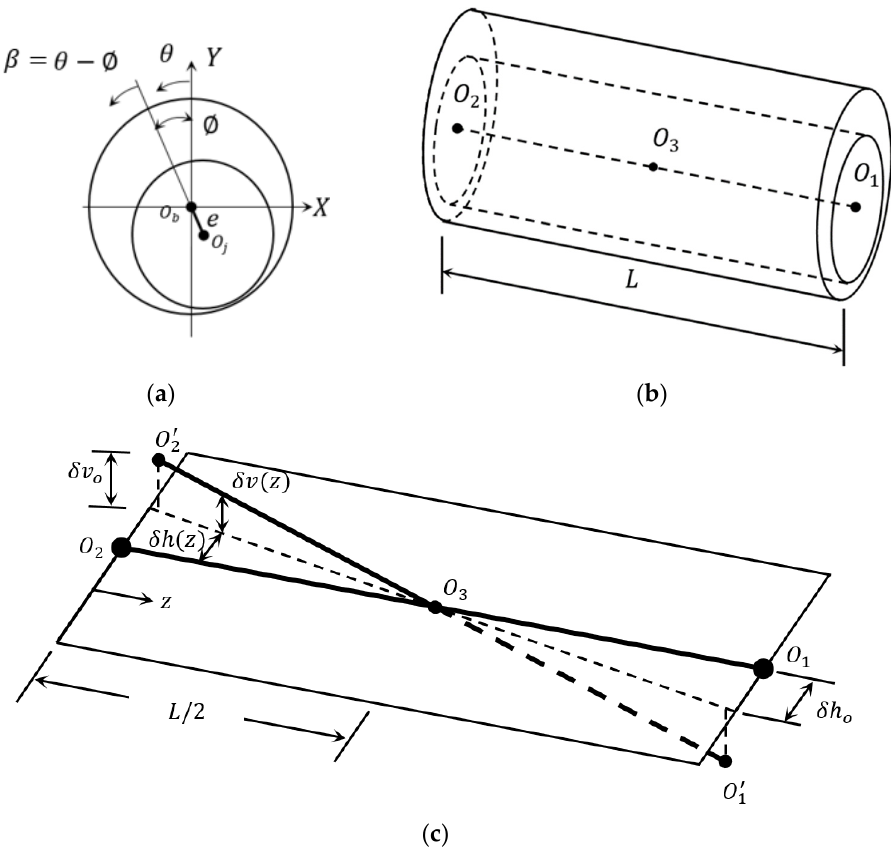
Figure 1. Schematic drawing of the journal-bearing. ( a ) Side view of aligned bearing, ( b ) 3D representation and ( c ) misalignment model used in this work.